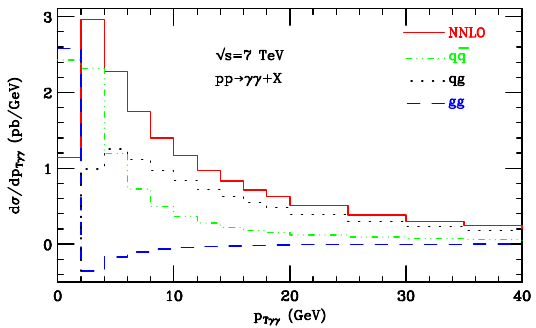
Figure 14 . The NNLO cross section dσ/dp Tγγ at central scales in the low- p Tγγ region of figure 13- right. The NNLO result is decomposed in the contributions of different initial-state partonic chan- nels: q ¯ q (green dot-dashed), qg (black dotted) and gg (blue dashed). The box gg amplitude only contributes in the first (lowest- p Tγγ )